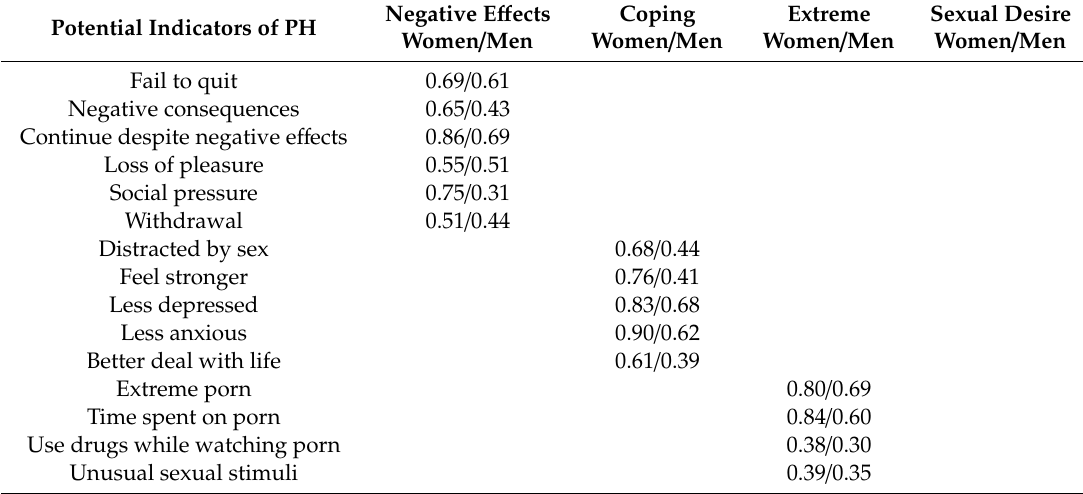
Table 2. Factor loadings of the variables in the exploratory factor analysis (EFA). Indicators with factor loadings in bold pertain to the factor column they are